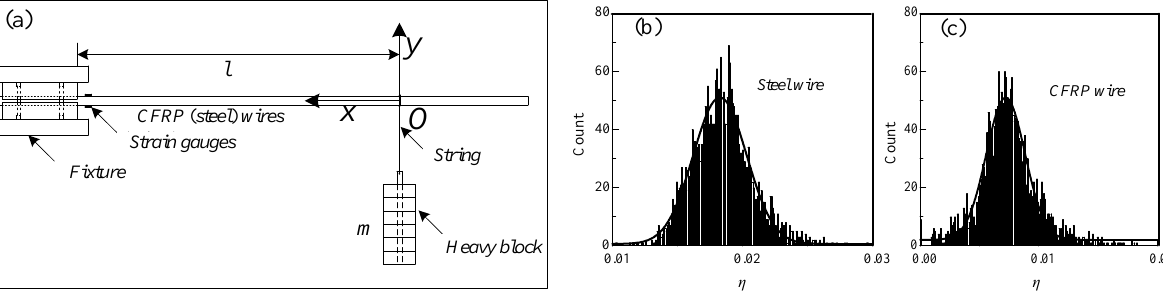
Figure 4. ( a ) Bending deformation experiments of steel and CFRP wires; ( b ) distribution of energy loss coefficient for steel wires; ( c ) distribution of energy loss coefficient for CFRP